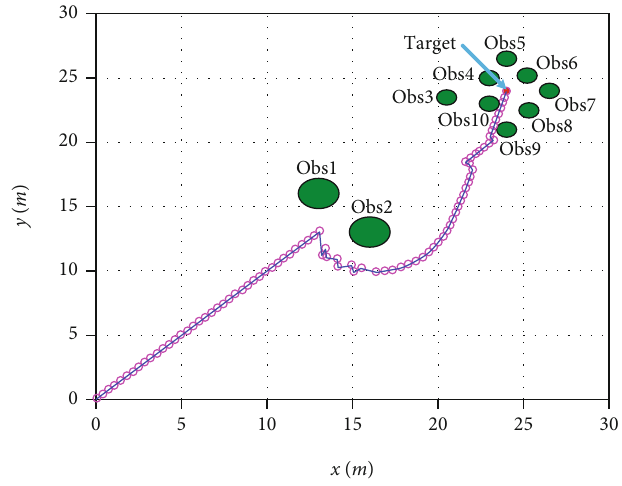
Figure 9: Scenario 2: the result of path planning of the proposed algorithm.